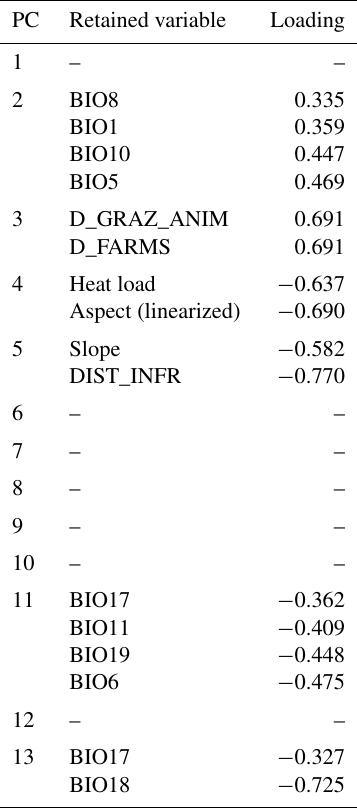
Table 2. Principal component analysis and selected predictors. For each principal component we retained only those variables with that component (Booth,